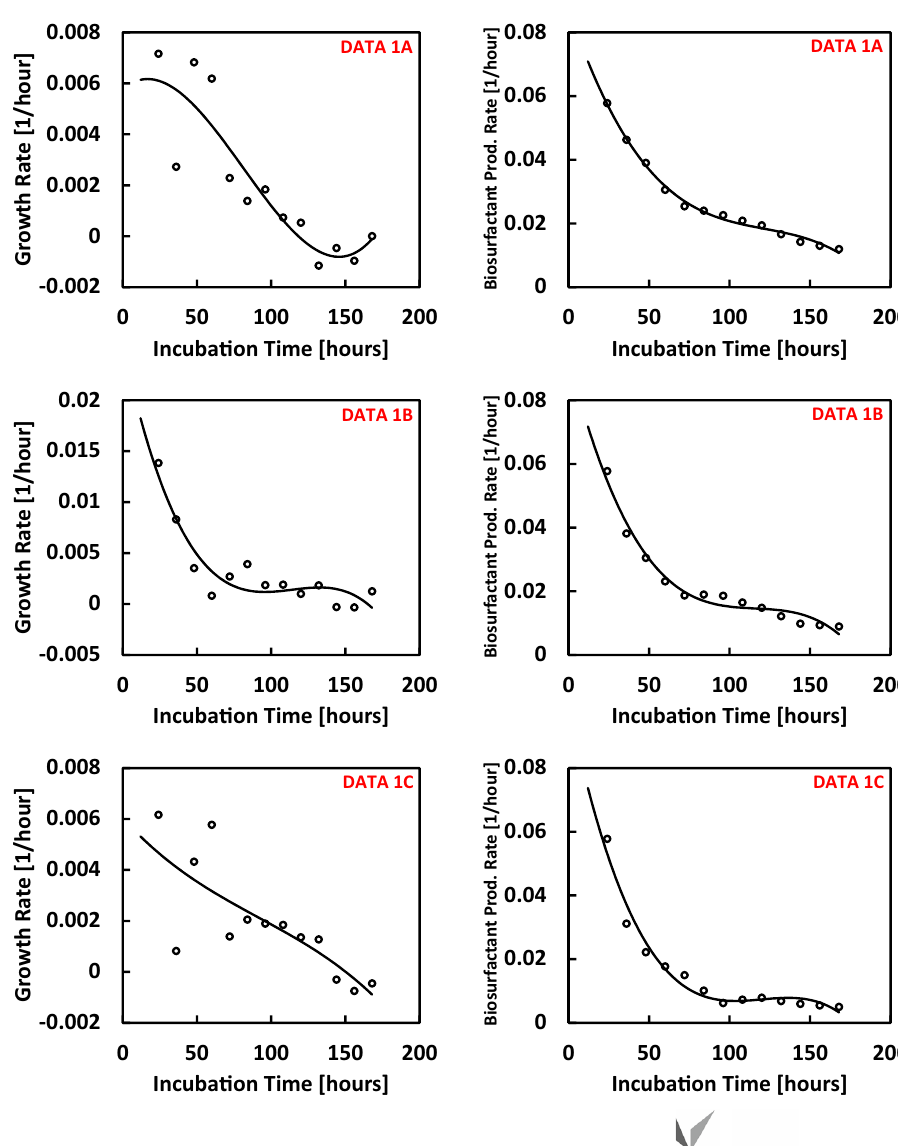
Fig. 4 Rate estimation model (REM). The first and second columns are for bacteria and biosurfactant, consecutively. The dotted data are calcu- lated with the proposed REM (Eq. 11) from DATA 1, which are then captured by polynomial regression (third degree) to pro- vide continuous time-dependent growth rate and biosurfactant production